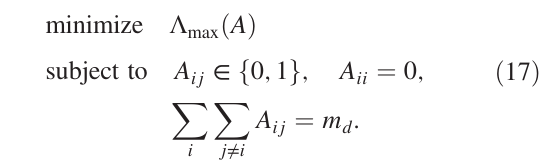
FIG. 4. Sensitive dependence of the Laplacian eigenvalue λ 2 on link density ϕ for undirected networks of size n ¼ 50 . Each curve indicates λ 2 normalized by the network size n , relative to the link density ϕ . (Plots of λ 2 =n itself can be found in Supplemental Material, Fig. S1 [58].) The blue curve shows the result of a single run of SA to maximize λ 2 with a fixed number of links. Each point on the magenta curve is the average over 1000 realizations of the ER random networks with connection probability ϕ . The orange and red curves indicate the MCC networks for n ¼ 50 [Eq. (12)] and in the limit of n → ∞ [Eq. (15)], respectively. Notice the square-root singu- larity on the left of points ϕ ¼ ϕ l ¼ ð l − 1 Þ = l , l ¼ 2 ; 3 ; … , on the red curve. The green dot near one of these singularity points indicates the UCM network with l ¼ 2 and k ¼ 25 , which achieves the upper bound λ 2 ≤ ⌊ ϕ ð n − 1 Þ ⌋ shown by the black (piecewise) smooth function, while the square-root singu- larity becomes progressively more visible (verified numeri- cally in Fig. S2(a) of Supplemental Material [58]).